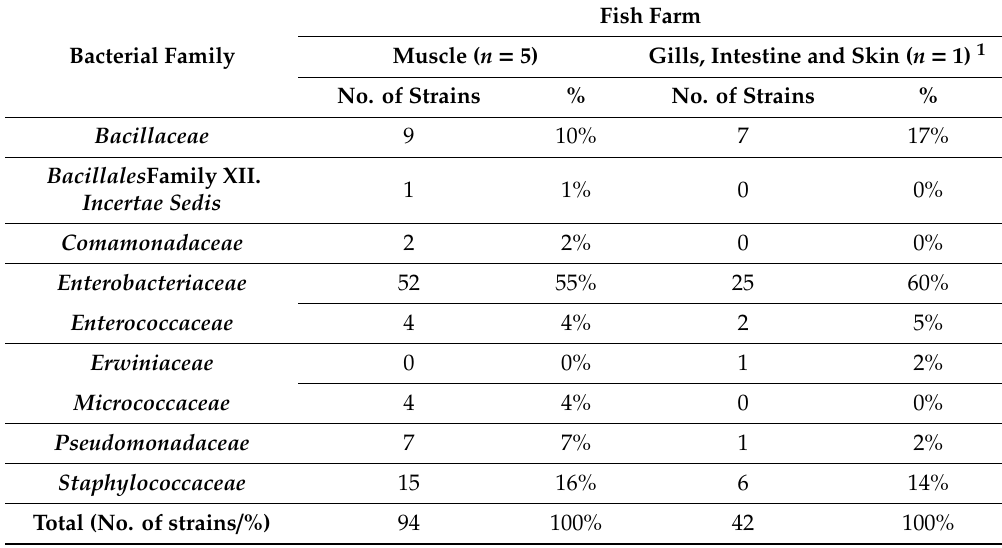
Table 4. Bacterial families of the 136 strains recovered from muscle, gills, intestine and skin samples.